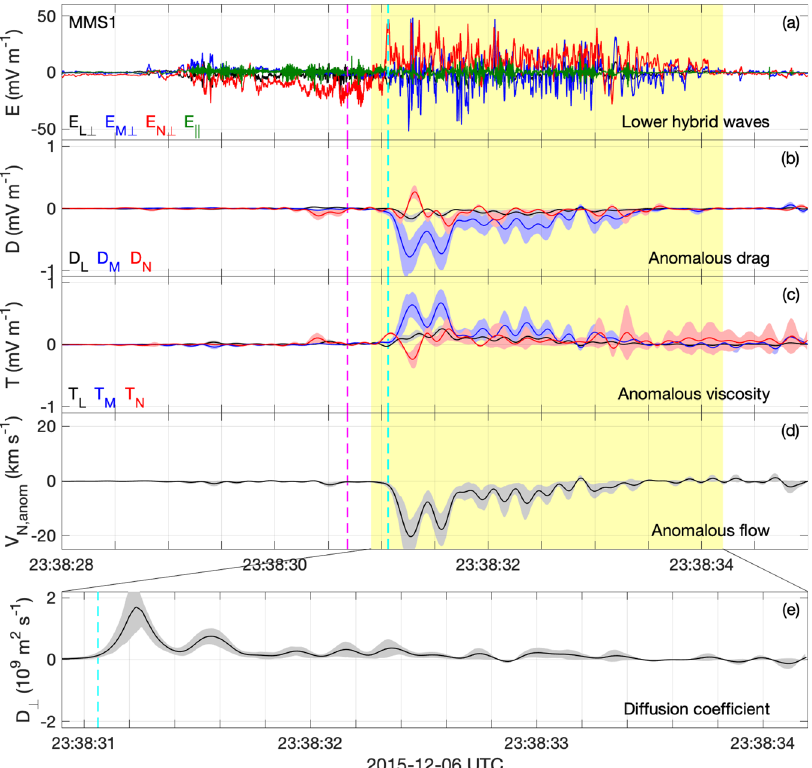
Fig. 3 Lower hybrid waves and anomalous terms. Observations of lower hybrid waves and parameters describing anomalous plasma phenomena observed at the magnetopause. The anomalous terms are calculated using all four MMS spacecraft (see Methods, subsection Estimating the anomalous terms). The anomalous terms are negligible at the neutral point (magenta dashed line), and signi fi cant when lower hybrid waves are present. The separatrix is indicated by the cyan line. The anomalous drag and viscosity essentially cancel leaving no signi fi cant contribution to the reconnection electric fi eld, while there is signi fi cant anomalous fl ow from high to low density, corresponding to a large diffusion coef fi cient. a Perpendicular and parallel components of E of lower hybrid waves in LMN coordinates (Fig. 2c) observed by MMS1. b , c Anomalous drag and viscosity, D and T , in LMN coordinates. d Anomalous fl ow V N,anom in the normal direction. The yellow shaded region in panels ( a – d ) indicates the interval when lower hybrid waves are observed. e Diffusion coef fi cient D ⊥ . The colored shaded regions associated with the anomalous terms indicate the uncertainty in the calculation based on the uncertainties in the particle moments and electric fi eld (see Methods, subsection Estimating the anomalous